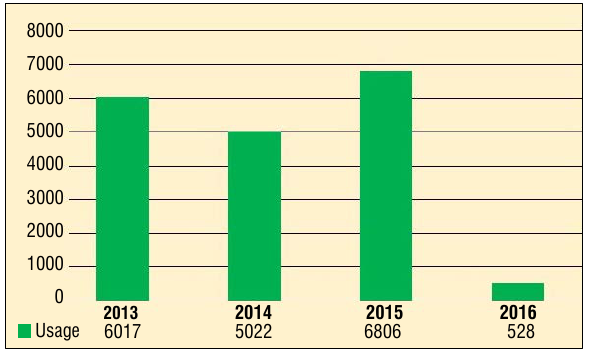
Figure 5: Usage of articles published in South African Journal of Libraries and Information Science between 2013 and 2016,